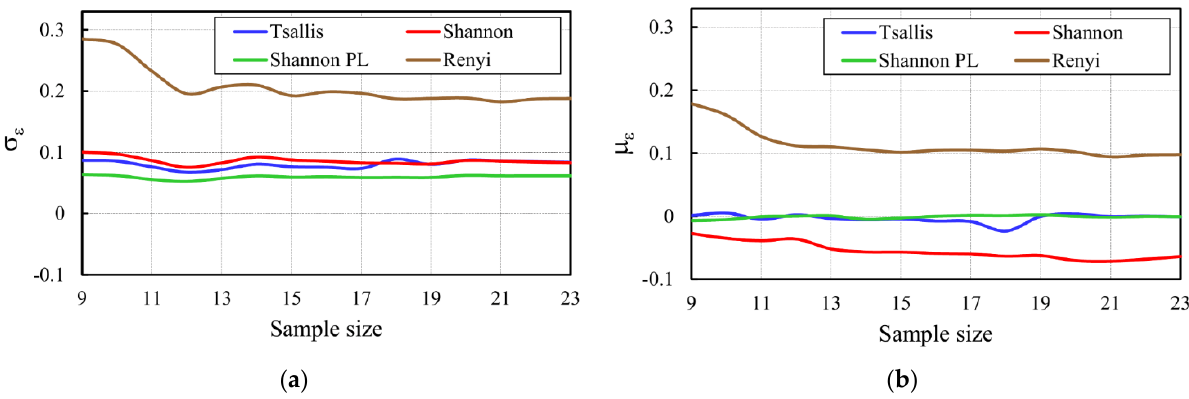
Figure 5. ( a ) The standard deviation and ( b ) mean value of the Gaussian error distribution ( σ ε and μ ε ) of shear stress versus 15 calibration tests with different sample sizes (SS = 9 to SS = 23) in four entropy models.